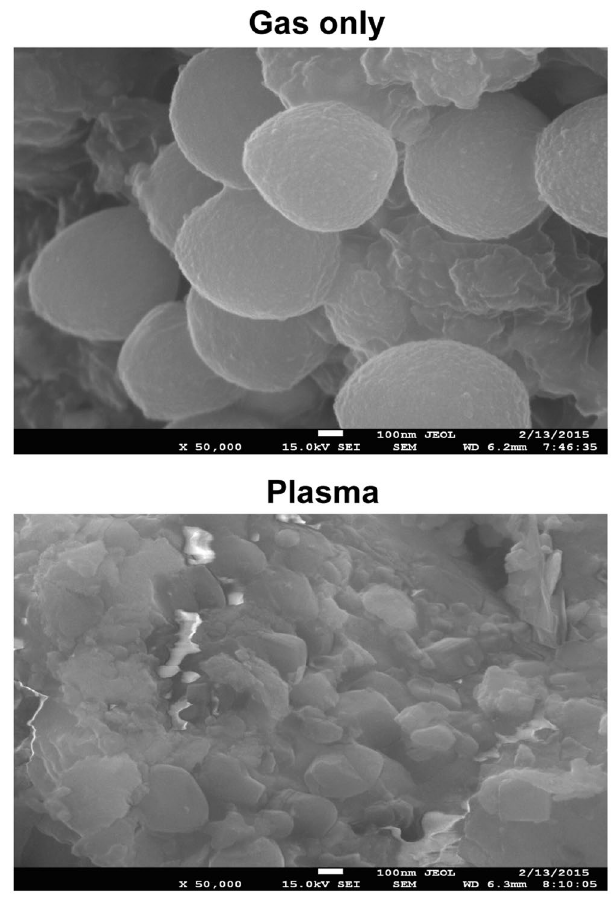
Figure 3. Scanning electron micrographs of S . aureus in artificial saliva after 5-min treatment with gas only (upper) or plasma (lower). Magnification,